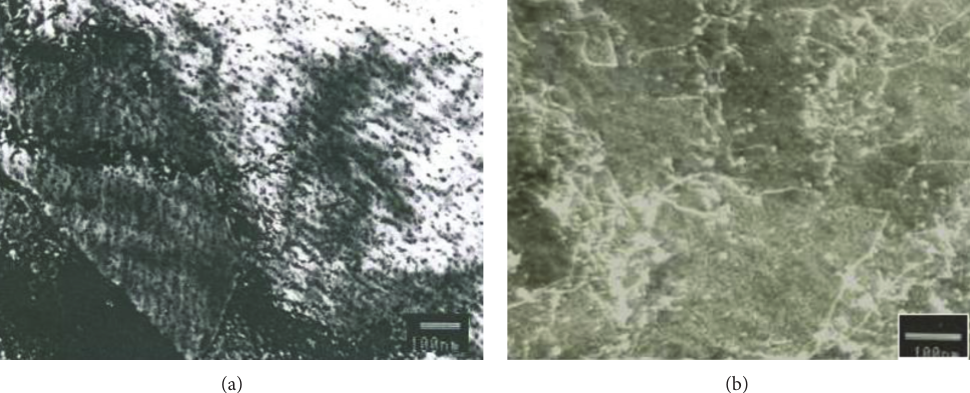
Figure 2: Niobium precipitates in hot-rolled strip (2). (a) Deformation induced series of niobium precipitates. (b) Interaction of precipitates and dislocations.